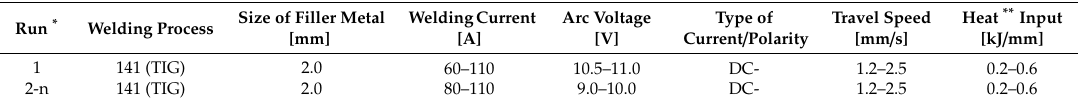
Table 4. Welding parameters for test